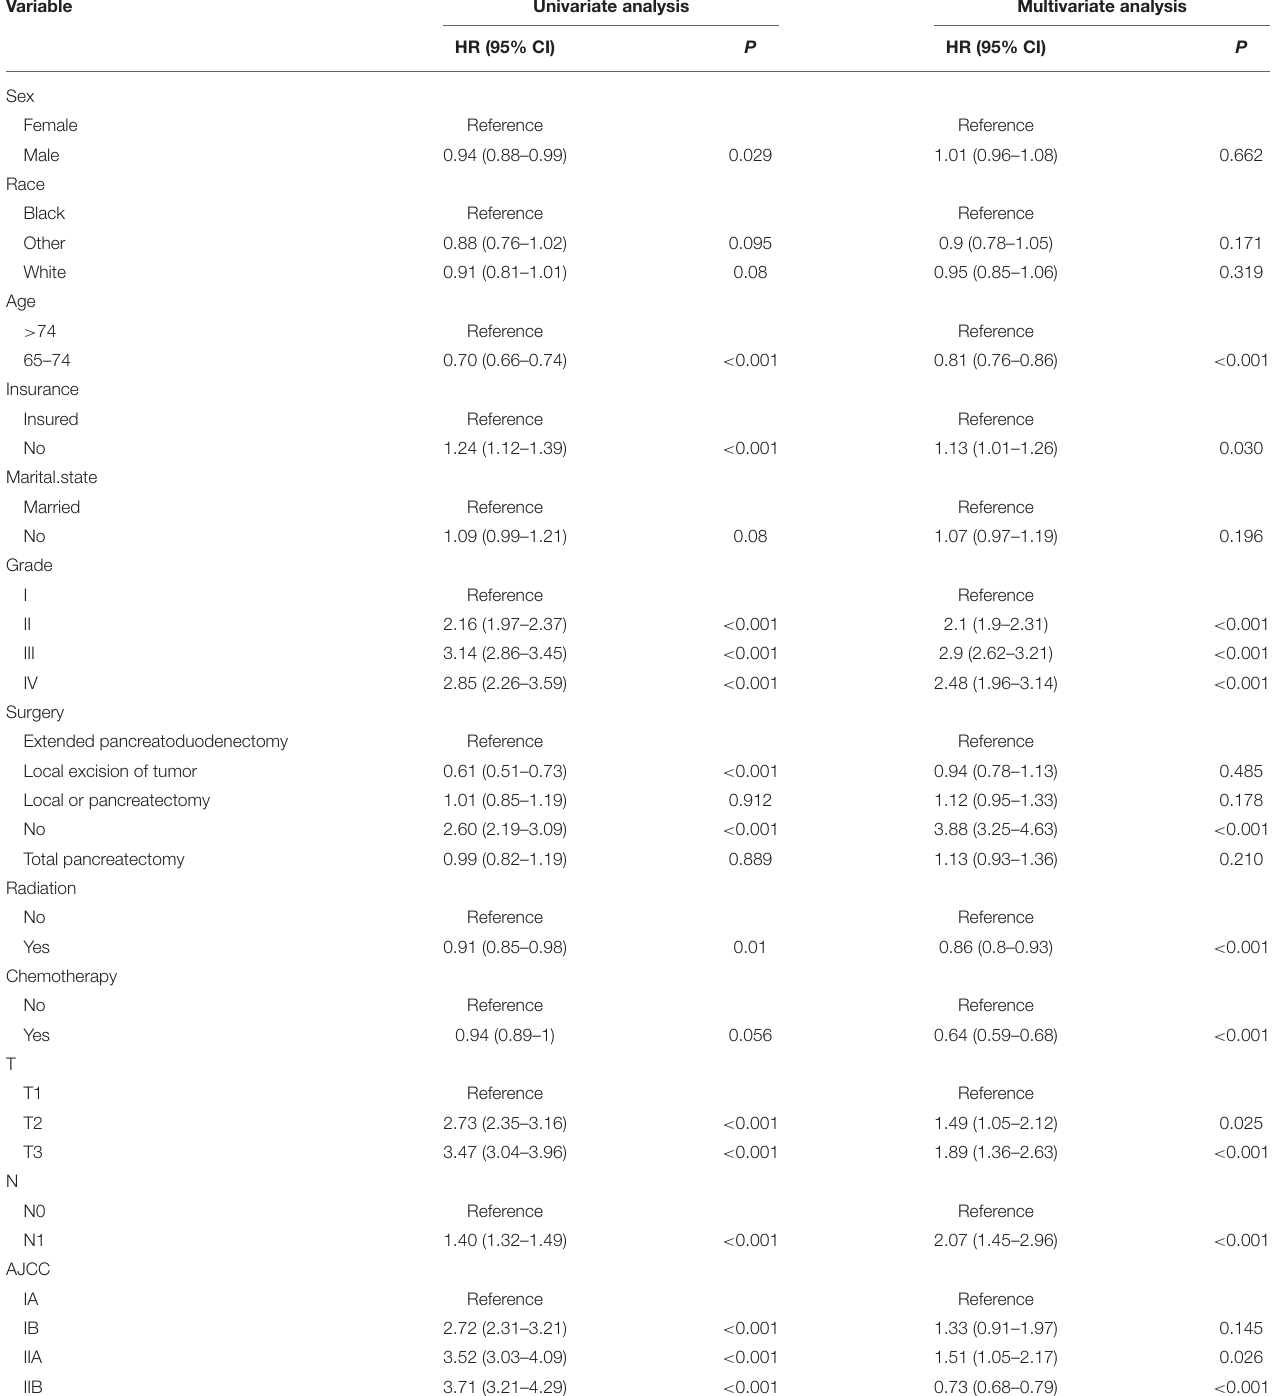
TABLE 2 | Univariable and multivariable Cox regression analysis of OS in training